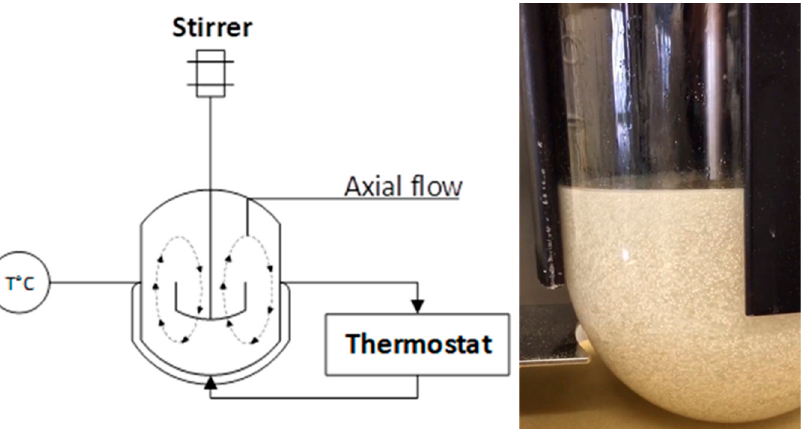
Figure 6. Flowsheet and picture illustrating the visibly homogenized lipase-catalyzed production of sugar alcohol monoesters using a stirred-tank reactor.